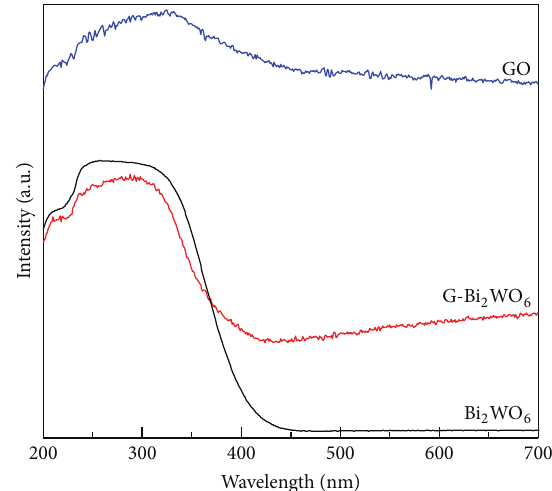
Figure 3: UV-Vis diffuse reflectance spectra of GO, pure Bi 2 WO 6 , and 1.2% G-BWO